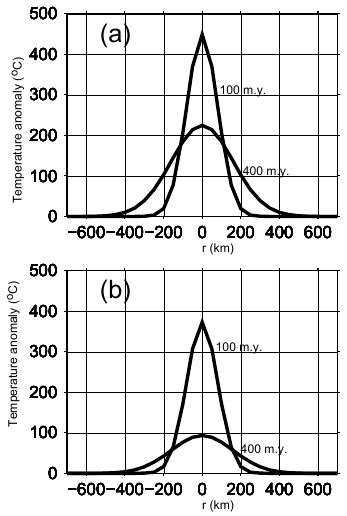
Figure 5. Temperature anomaly distributions in 1-D (a) and 2-D (b) conductive media with an interval of 300 million